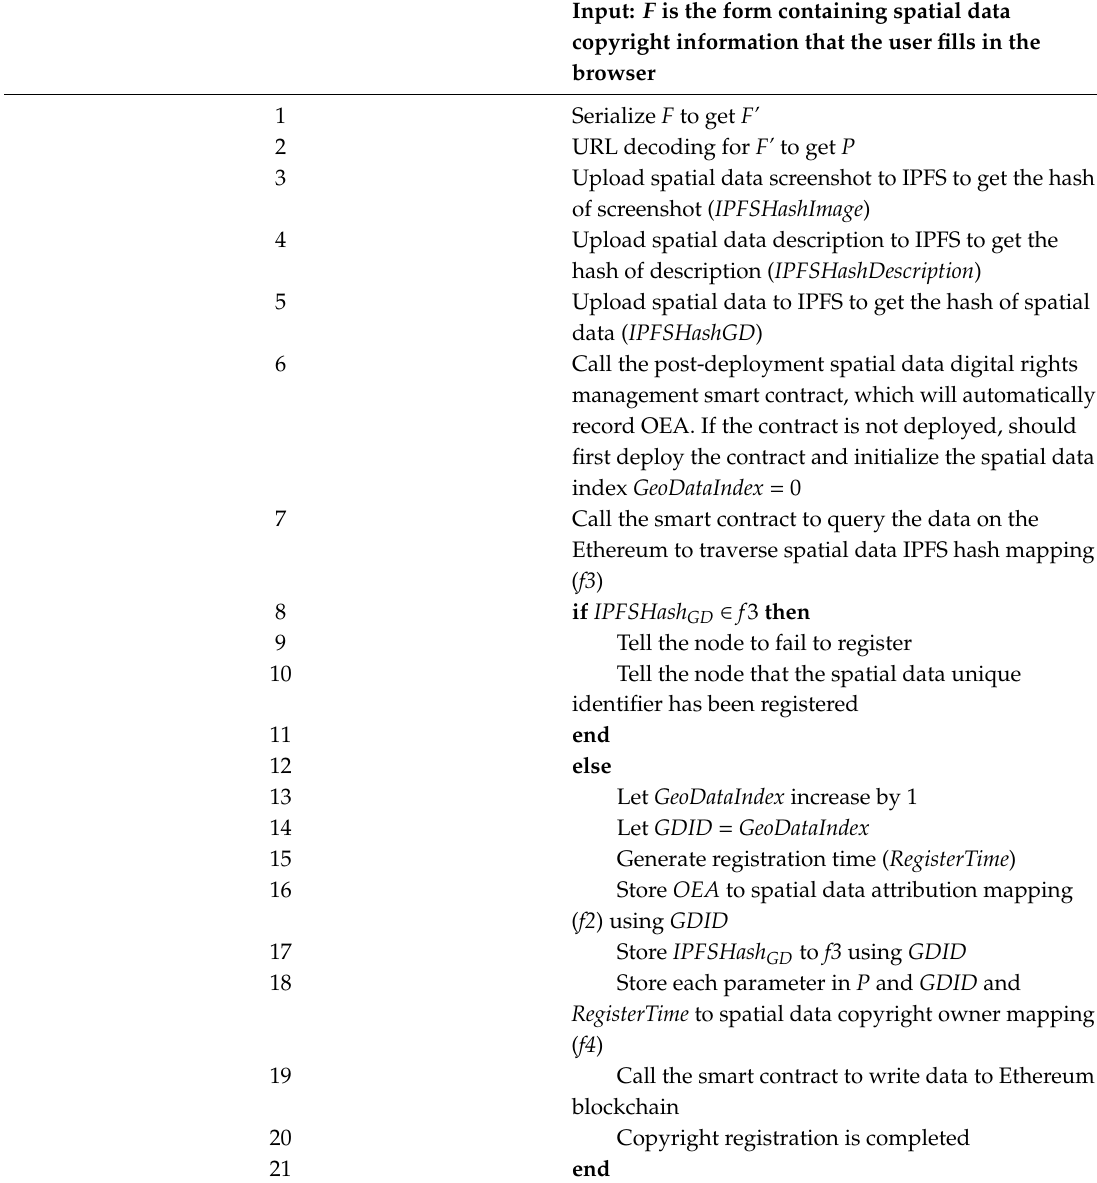
Algorithm 1. Spatial data copyright registration